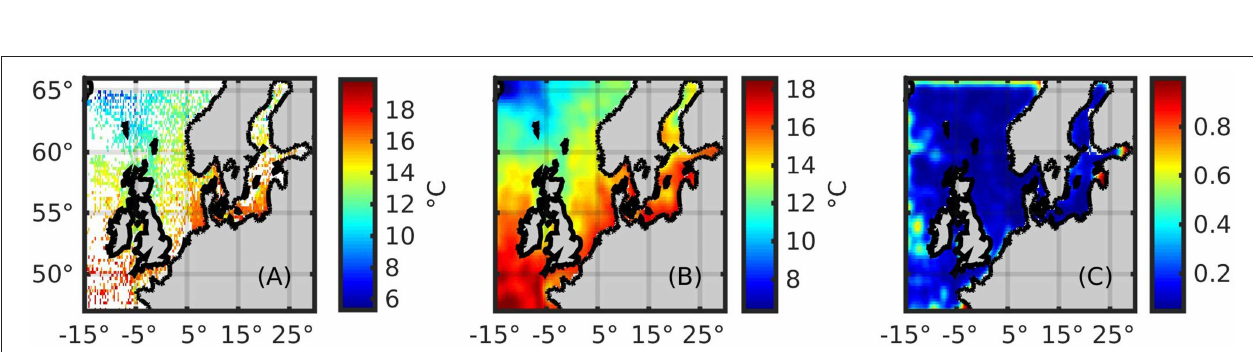
FIGURE 8 | TEMPERATURE, August 1976–1985, depth = 10m, decadal monthly mean values as box averages (A) , interpolated field (B) (both in ◦ C) and the corresponding relative interpolation error ( C , dimensionless).